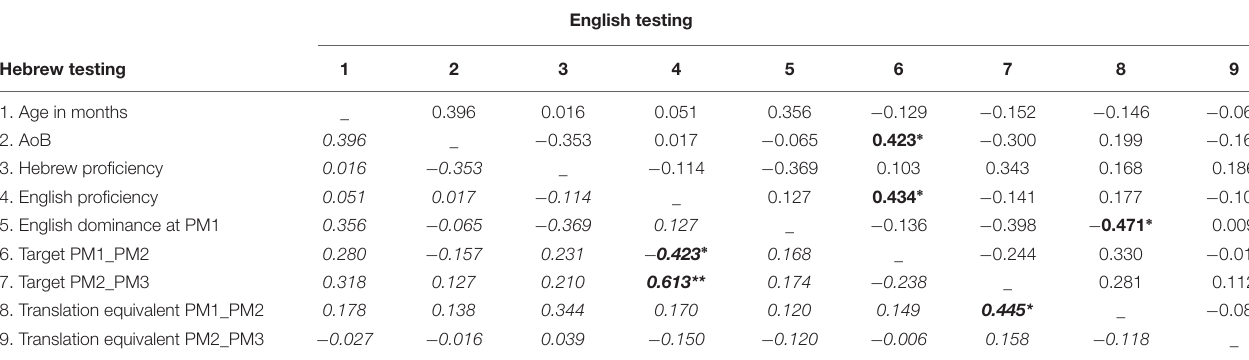
TABLE 5 | Correlation matrix of individual difference with HL and SL gains for target items and translation equivalents for each language